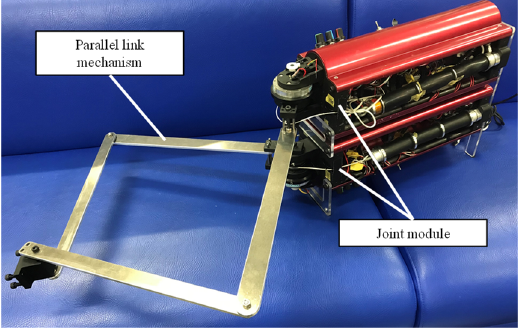
Figure 25. Picture of application examples of the Joint Module (four-section parallel link mechanism).